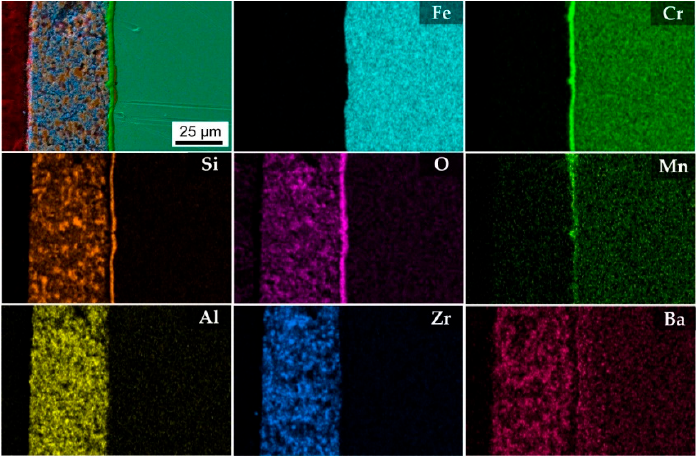
Figure 9. SEM/EDXS cross-sections of layer D4 after oxidation tests in water vapor at 1000 ◦ C for 96 h.